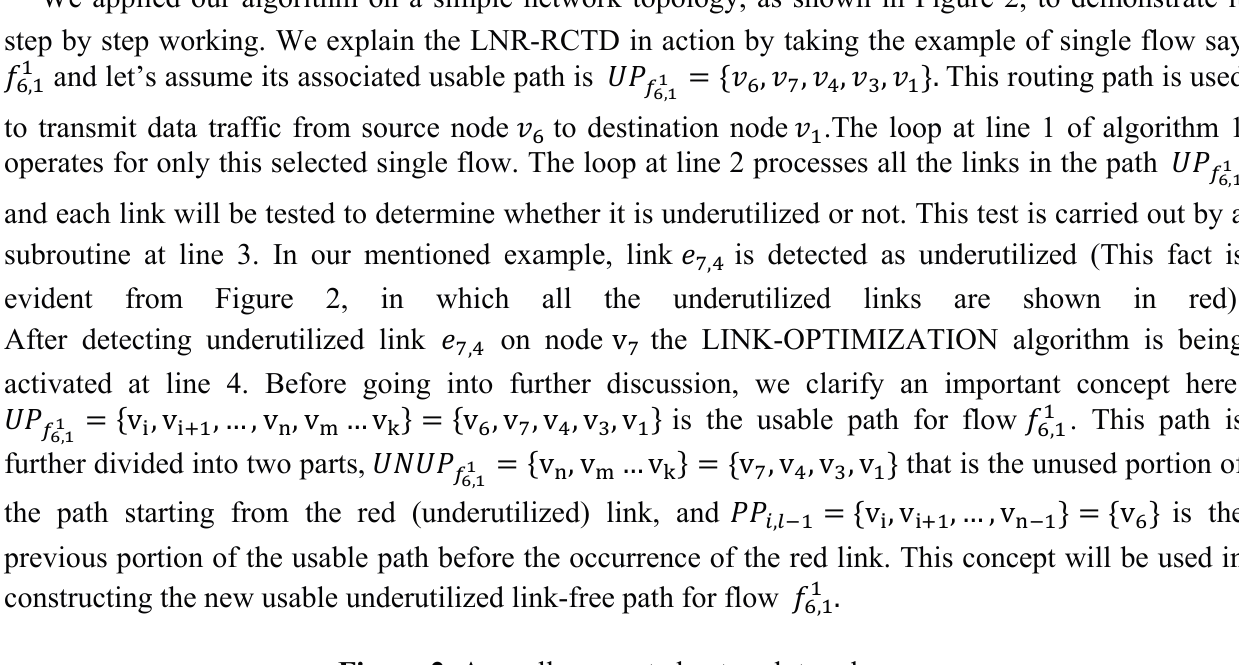
Figure 2. A small connected network